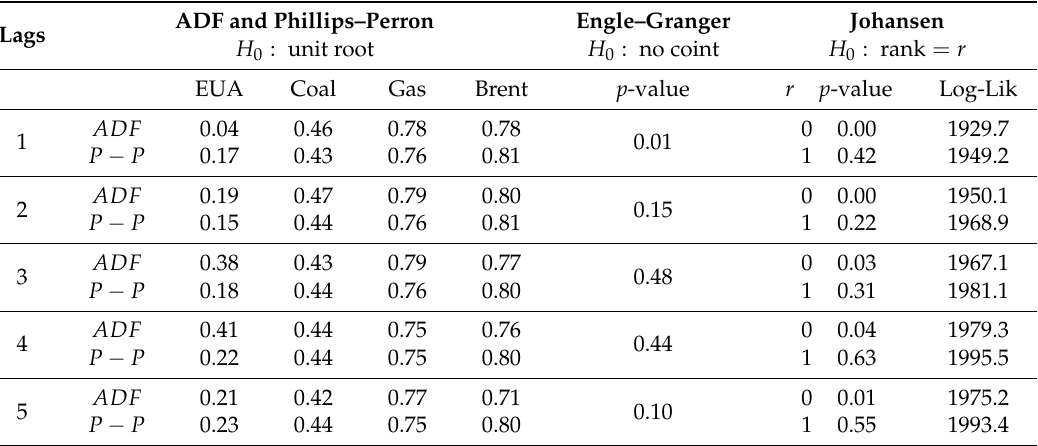
Table 4. (MacKinnon) p -values corresponding to Augmented Dickey–Fuller (ADF) and Phillips–Perron (P-P) unit root tests (left columns) and corresponding to Engle–Granger and Johansen cointegration tests (right columns) for the weekly forward